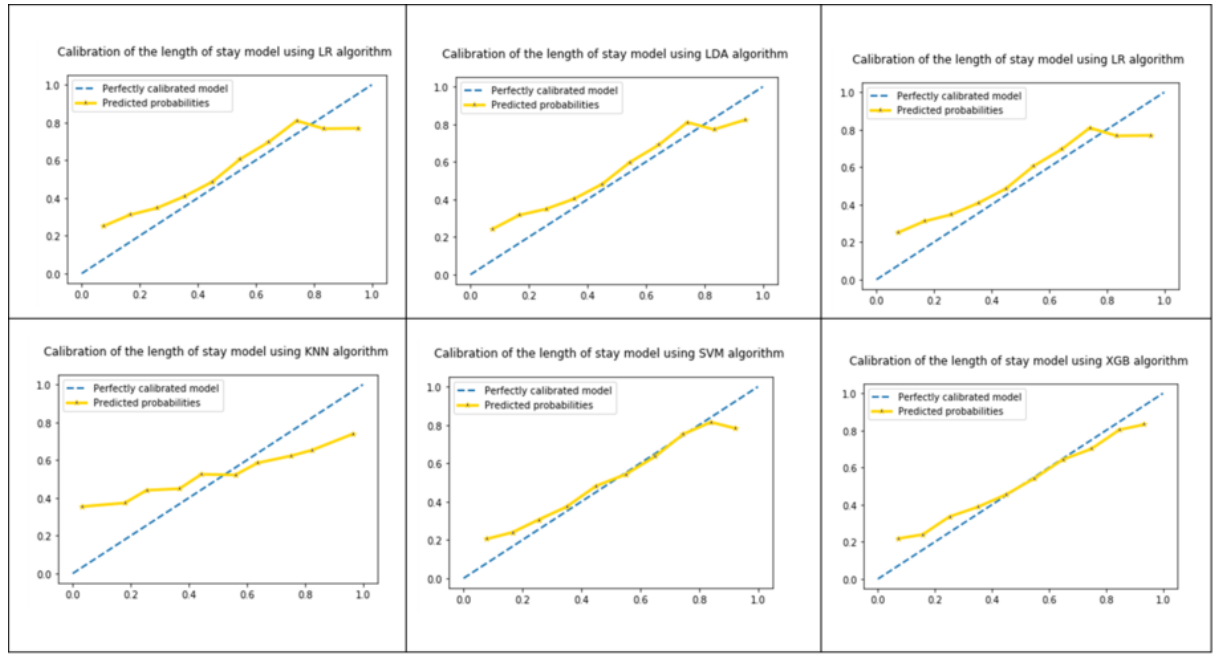
Figure 11. Probability calibration curves of the length of stay model for the six classification algorithms. LR: logistic regression; LDA: linear